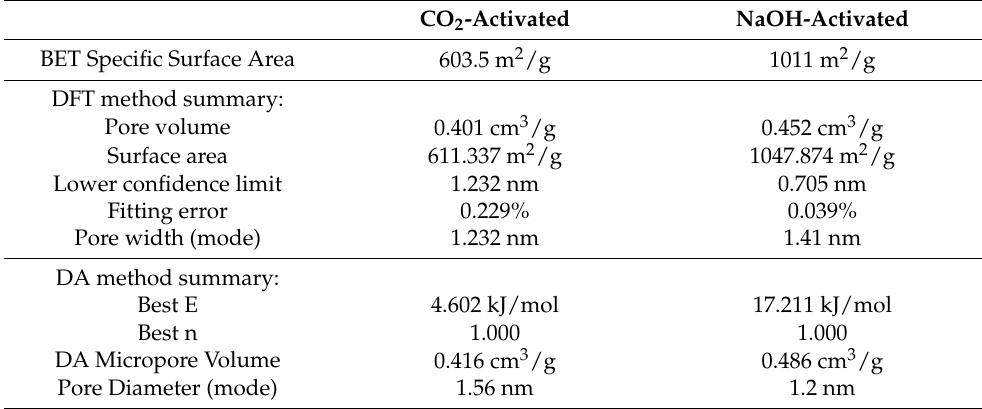
Figure 2. N 2 adsorption–desorption isotherms and pore size distributions calculated by DFT; ( a , b ) for physically CO 2 -activated carbon; ( c , d ) for chemically NaOH-activated carbon; The insets are the pore size distribution calculated by the DA method. Table 1. Structural properties of the activated carbon calculated from N 2 adsorption